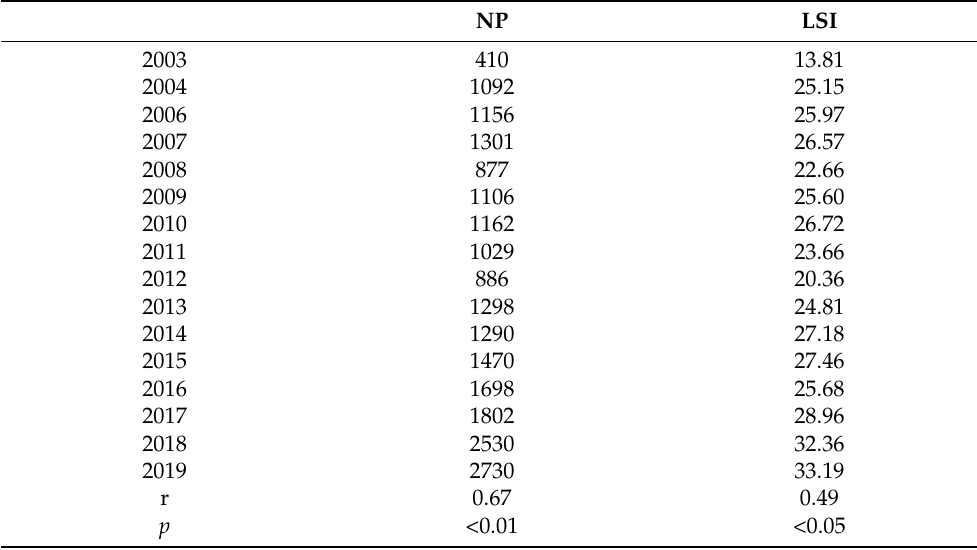
Figure 4. Results of landscape classification in the area of sand mining activities. ( a – f ) Multi-year wetland landscape classification; ( g ) Changes in wetland landscape area from 2000 to 2020. Table 3. Landscape indices within the area affected by sand mining activities during the dry season from 2000 to 2020.